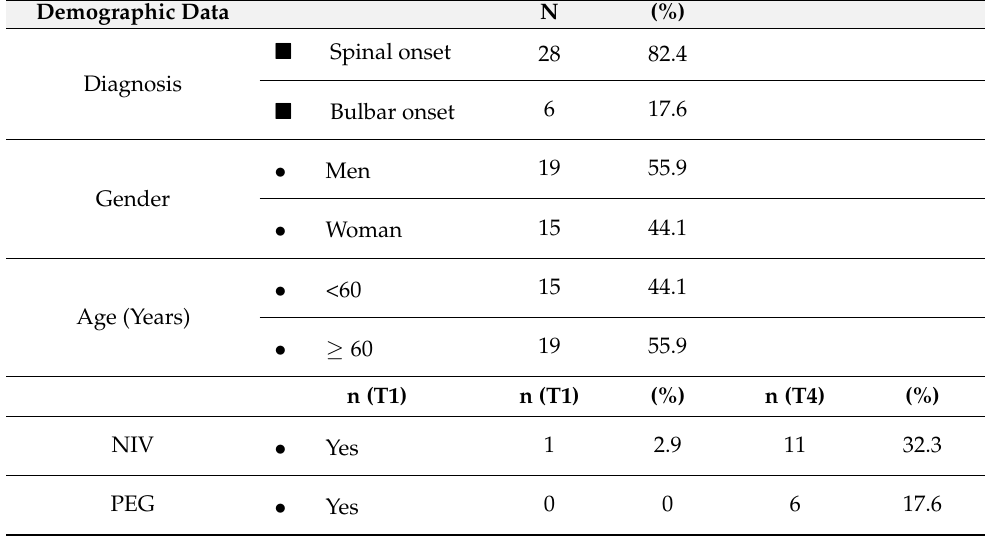
Table 1. Categorical clinical variables of subjects.